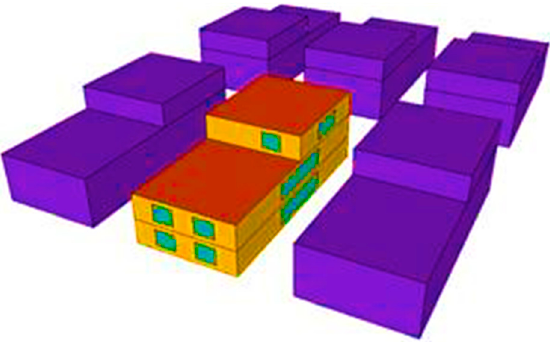
Figure 7. The house model surrounded by shaded buildings (Google Sketchup).